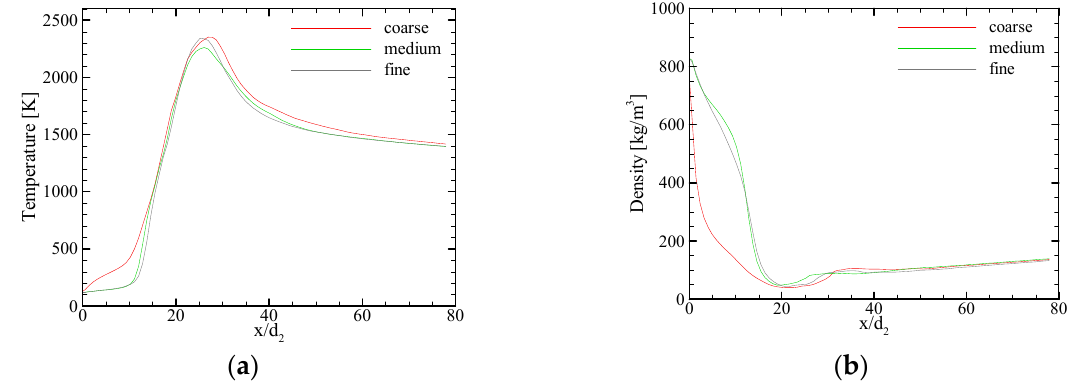
Figure 4. Time-averaged flow properties along central-axis with different grid resolution: ( a ) mean temperature; ( b ) mean density.